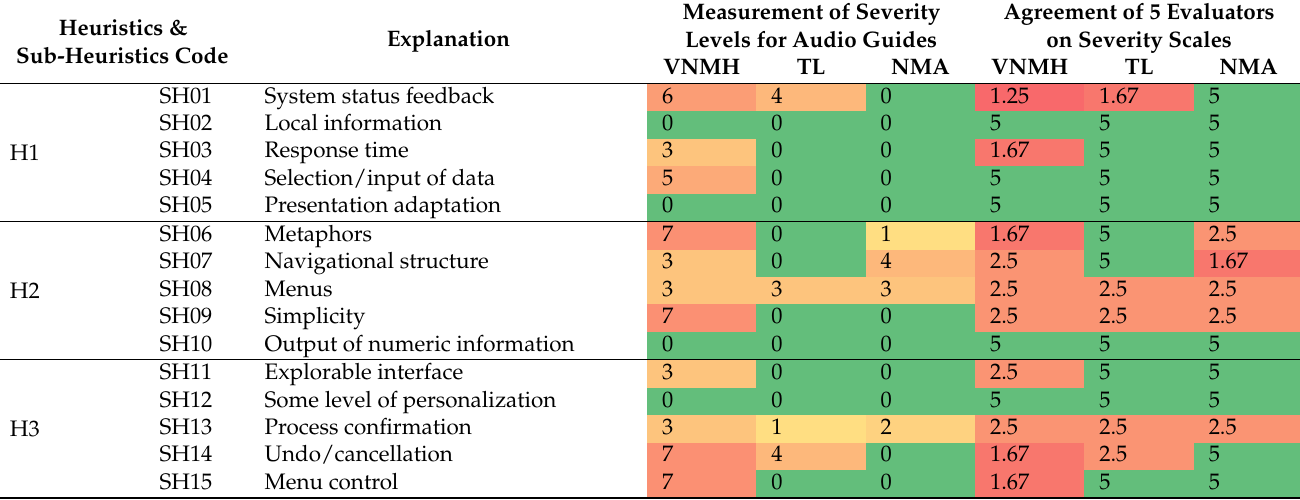
Table 2. Measurement of severity levels for audio guides (left heat map with red is the highest and green is the lowest values); and the agreement of five evaluators on severity scales (right heat map with red is the lowest and green is the highest